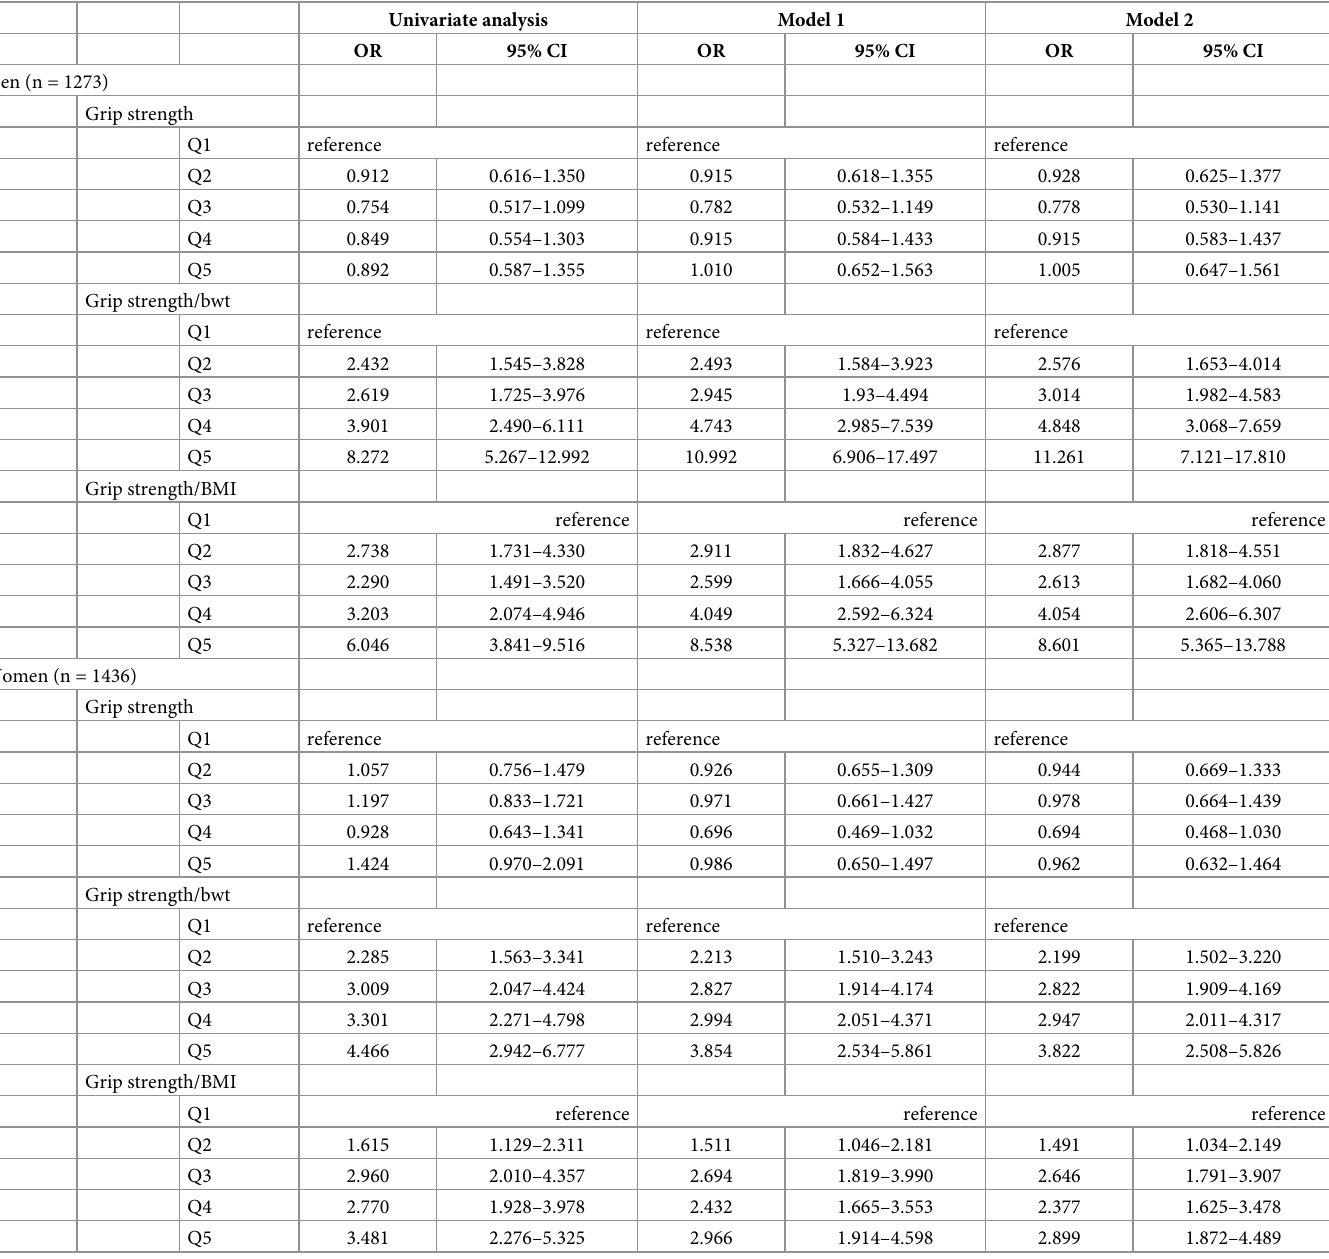
Table 4. Odds ratios of each quintile of grip strength and normalized grip strength for metabolic